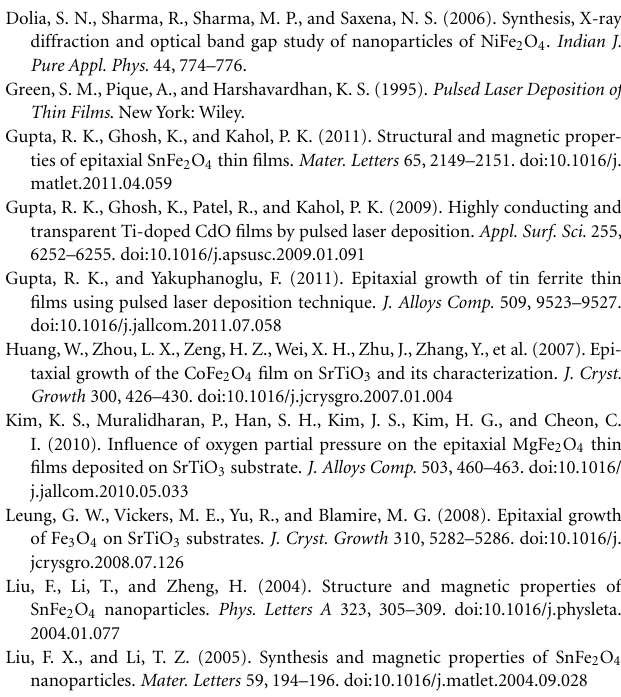
measurements confirm the epitaxial nature of the tin ferrite